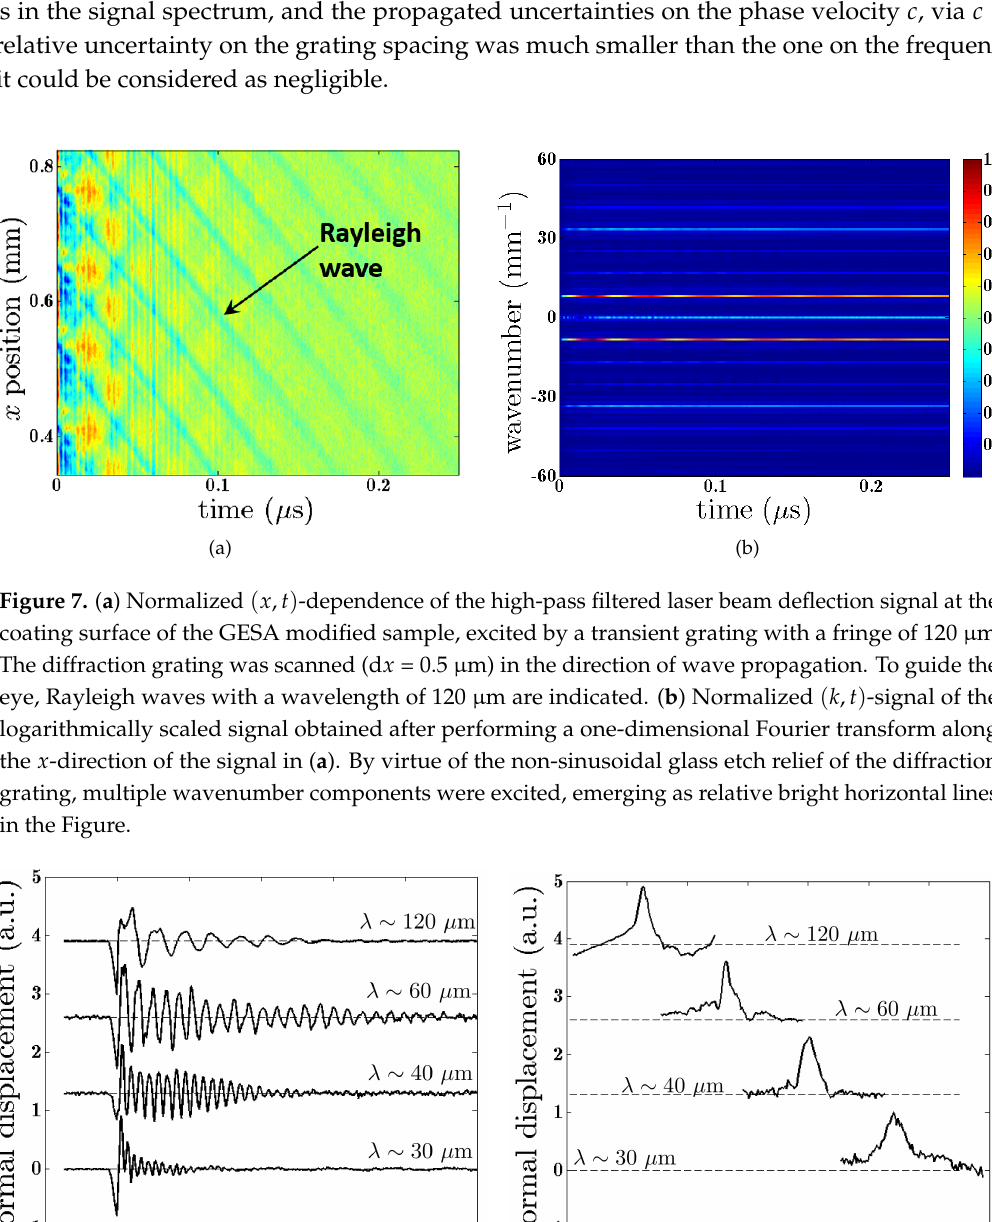
that it could be considered as negligible.